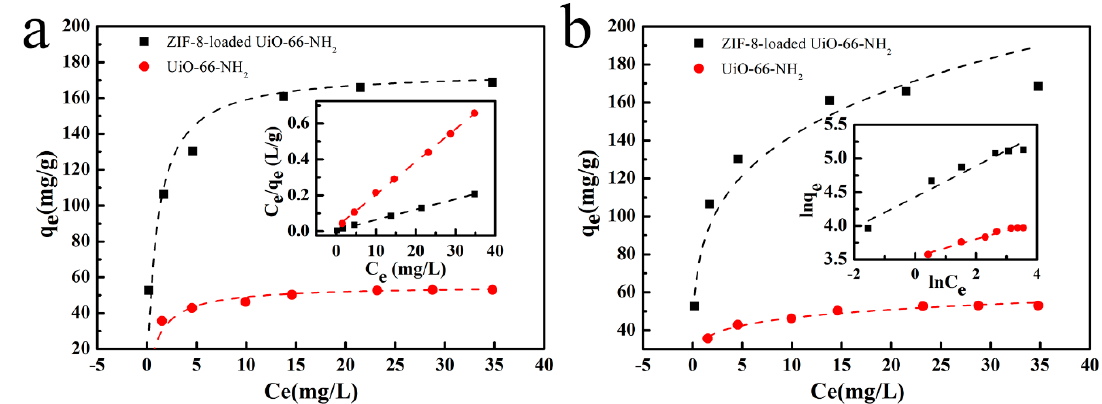
Figure 6. Langmuir ( a ) and Freundlich ( b ) isotherm models for the adsorption of methylene blue (MB) on UiO-66-NH 2 and zeolitic imidazolate framework-8 (ZIF-8)-loaded UiO-66-NH 2 . Table 2. Values of isotherm model parameters for the adsorption of methylene blue (MB) on UiO-66-NH 2 and zeolitic imidazolate framework-8 (ZIF-8)-loaded UiO-66-NH 2. Langmuir Isotherm Freundlich Isotherm Adsorbent